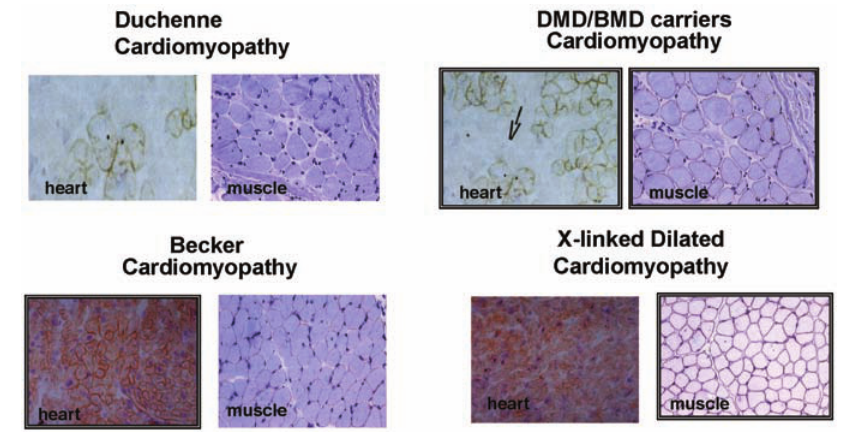
Figure 3. Immunostaining of dystrophin at muscle and cardiac level in the different types of dystrophinopathy. Top-left) Complete absence of dystrophin in heart and skeletal mus- cle in Duchenne muscular dystrophies (DMD); Bottom-left) Partial presence of dystrophin in heart and skeletal muscle in Becker muscular dystrophies (BMD). Top-right) Mosaic pat- tern of immunostaining of dystrophin in both heart and skeletal muscles in DMD/BMD carriers; Bottom-right) Complete absence of dystrophin immunostaining by anti-NH2 antibody in the heart (not in skeletal muscles) in X-linked dilated cardiomyopathy.